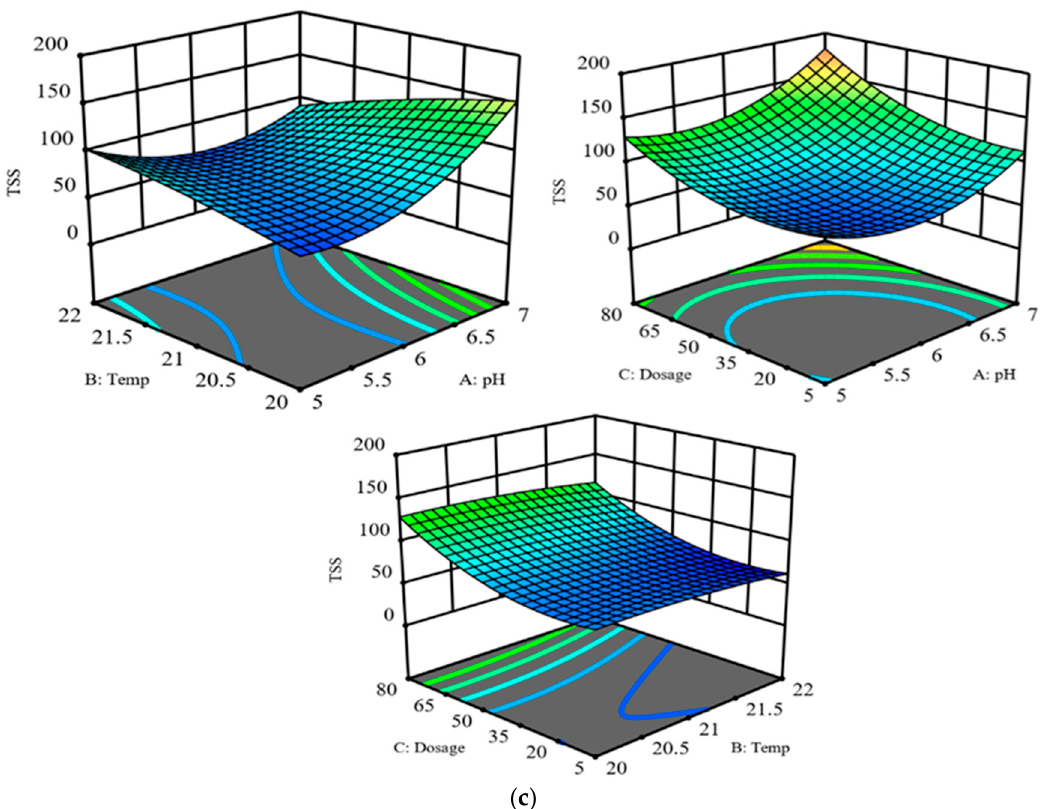
Figure 4. ( a ) 3D surface plot for TOC removal, ( b ) 3D surface plot for TN removal, ( c ) 3D surface plot for TSS removal.